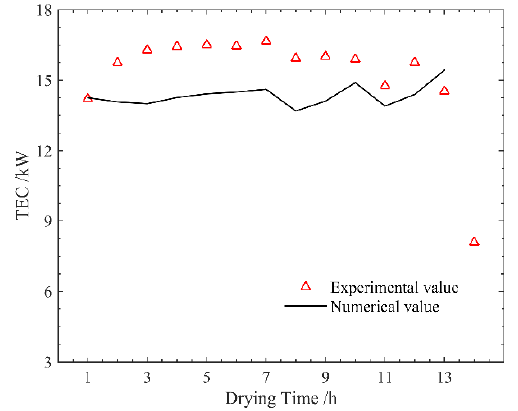
Figure 10. Energy consumption of the heat pumps.